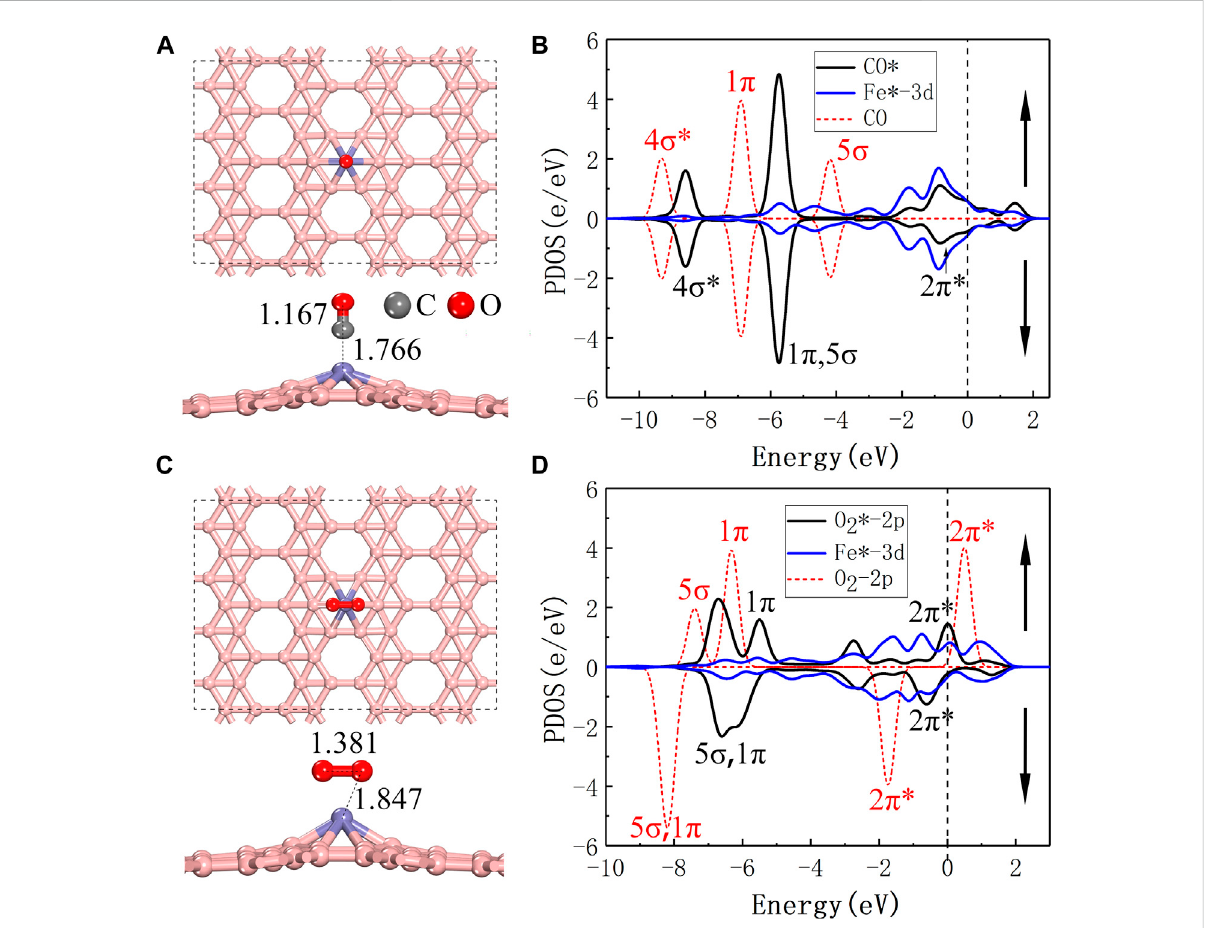
FIGURE 2 (A,C) are top and side views of the most stable con fi gurations of CO/O 2 adsorbed on Fe@ χ 3 -borophene, respectively. (B,D) are the spin polarizedpartialdensityofstatesfortheCO/O